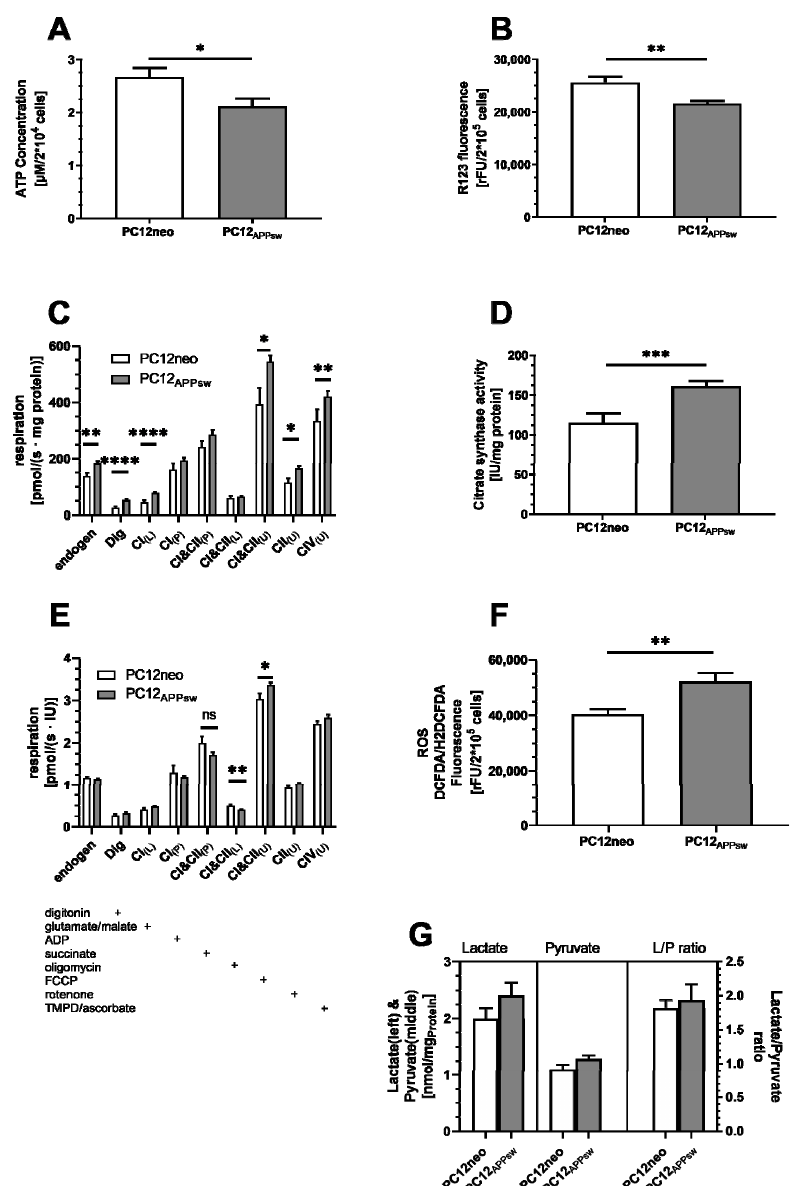
Figure 1. Comparison of mitochondrial and cellular parameters of PC12neo and PC12APP sw cells. ( A ) Adenosine triphosphate (ATP) level of 2 × 10 4 cells of both cell lines. ( B ) R123 fluorescence as a measure for mitochondrial membrane potential (MMP) level of 2 × 10 5 cells of both cell lines. ( C ) Respiration adjusted to samples’ protein content. Activities of the oxidative phosphorylation (OXPHOS) complexes were measured by adding substrates, inhibitors or uncouplers for each complex. The substance added is indicated by a “+” marker under the graph. States denoted by either (L) , (P) or (U) describe a leaked state due to lack of ADP or inhibited ATP synthase, coupled, physiological respiration in the presence of substrates for the specific complex or uncoupled respiration following the addition of FCCP. ( D ) Citrate synthase activity adjusted to the protein content of the samples. ( E ) Respiration adjusted to Citratesynthase activity. ( F ) ROS Level measured as DCFDA/H2DCFDA fluorescence of 2×10 4 cells. ( G ) Lactate and pyruvate concentration (left axis) adjusted to protein content and ratio of lactate/pyruvate (right axis). Data are displayed as mean ± SEM. n = 9–16. Statistical significance was tested via Student’s t -test (**** p < 0.0001, *** p < 0.001, ** p < 0.01, * p < 0.05, n.s. p > 0.05).